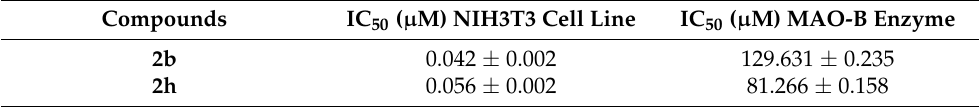
Table 3. IC 50 values of compounds 2b and 2h against the NIH/3T3 cell line. Compounds